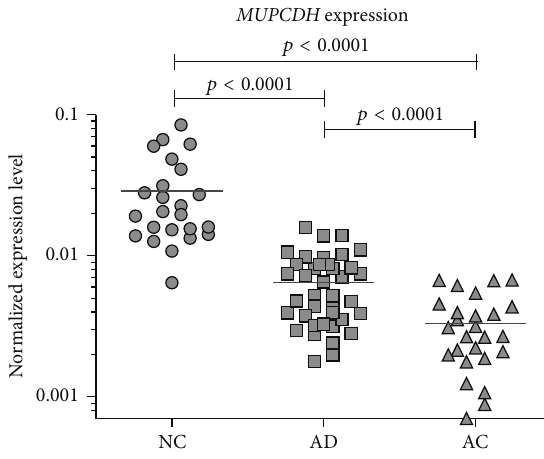
Figure 1: MUPCDH expression levels compared between normal colonic mucosa (NC), adenomas (AD), and carcinoma (AC) sam- ples; horizontal lines on graph indicate mean